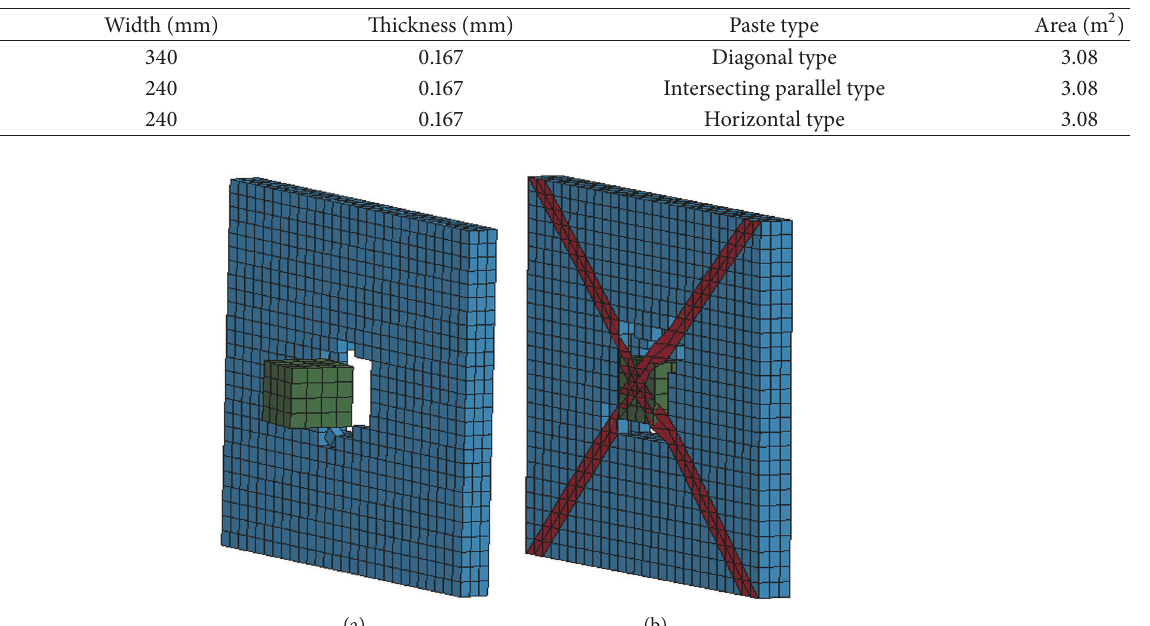
Table 3: Reinforcement scheme with different FRP arrangements.